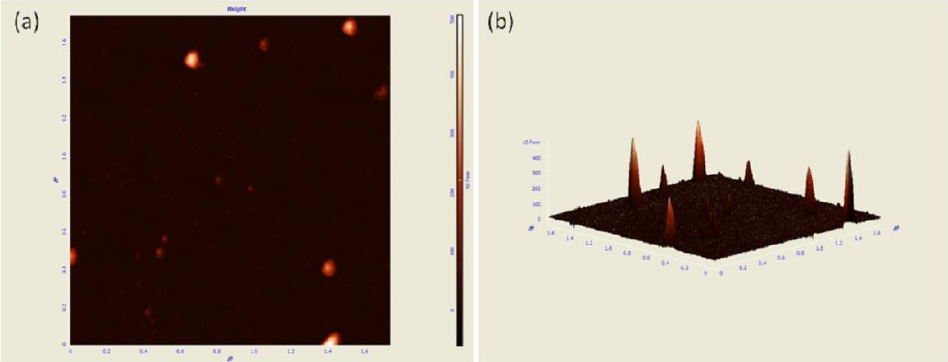
Figure 4. AFM image of silver nanoparticles. Morphological characteristic ( a ) and 3D topographic image ( b ) of silver